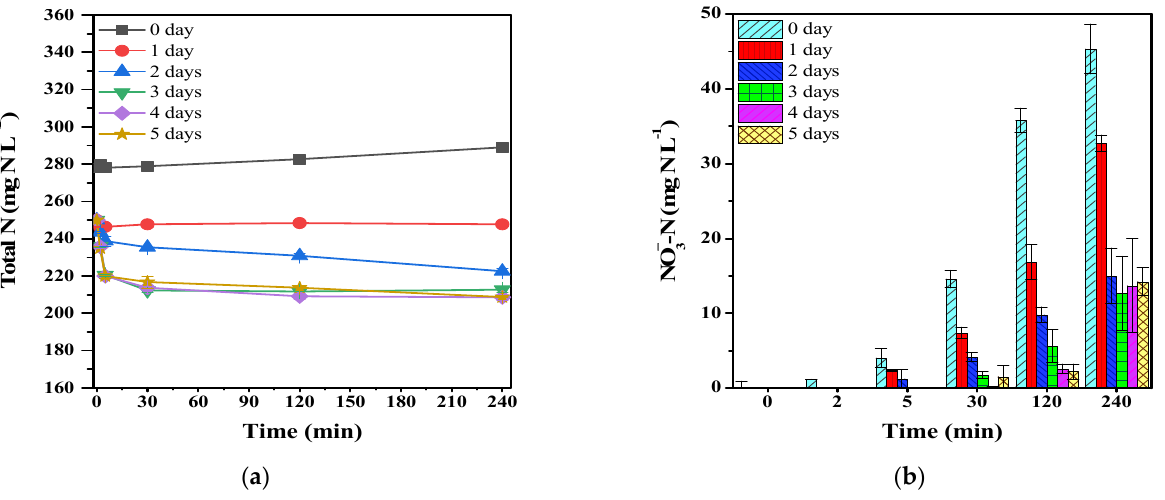
Figure 3. Variation in Total Nitrogen concentration (mg L − 1 ) ( a ) and nitrate production ( b ) in non- starved nitrifying cultures and after 1 to 5 days of starvation. Incubation conditions included tem- perature of 25 °C, initial NH 4+ -N concentration of 250 mg N L − 1 , and cell density of 500 mg TSS L − 1 , equivalent to 1.29 × 10 9 cells mL − 1 .